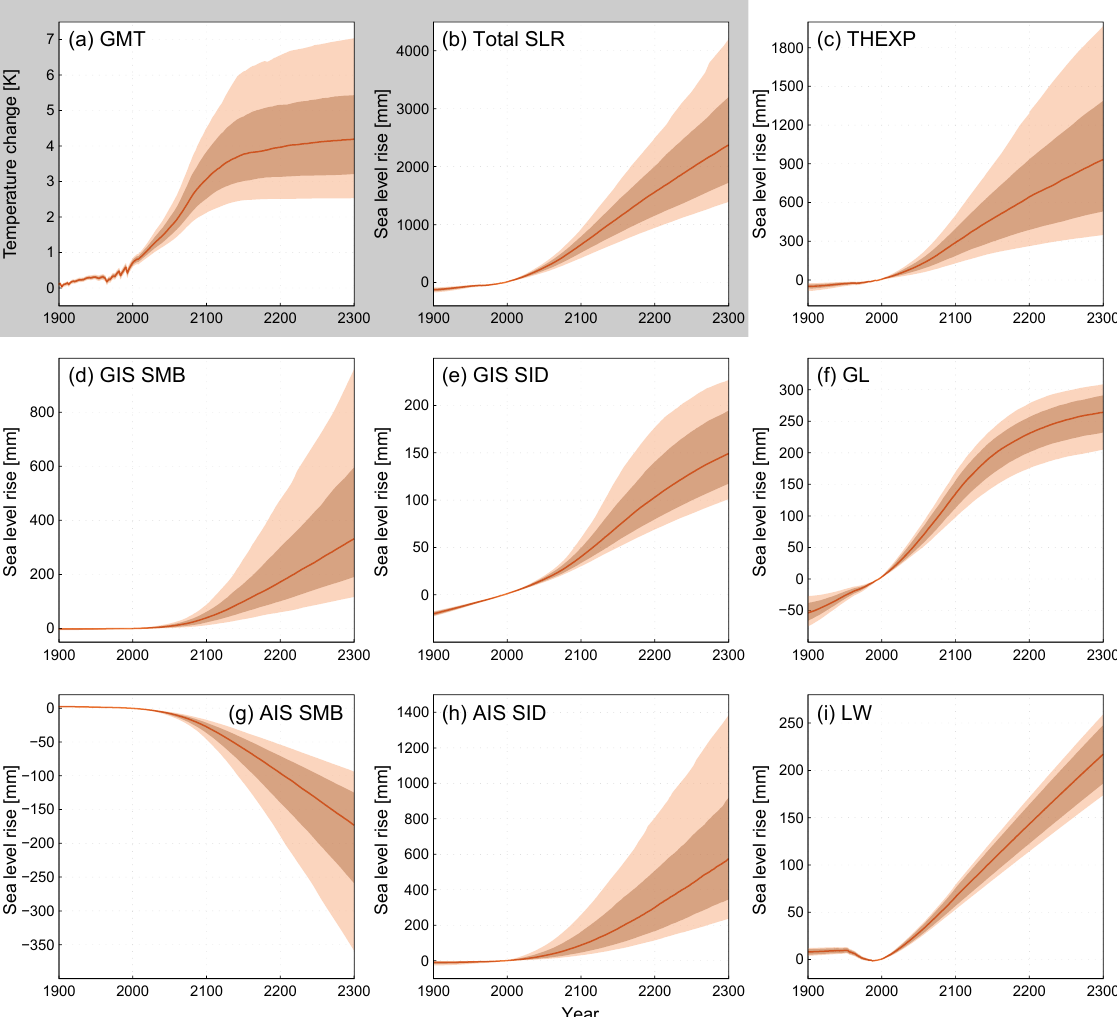
Figure A6. The 1900–2300 SLR projections resolved by the individual MAGICC sea level components for RCP6.0 in millimeters. We show median estimates, 66% ranges in darker shading, and 90% ranges in lighter shading for MAGICC GMT output relative to pre-industrial in panel (a) , total SLR in panel (b) , thermal expansion (THEXP) in panel (c) , Greenland ice-sheet (GIS) SMB and SID in panels (d) and (e) , global glacier (GL) in panel (f) , Antarctic ice sheet (AIS) SMB and SID in panels (g) and (h) , and land water LW in panel (i) . All sea level contributions are provided relative to